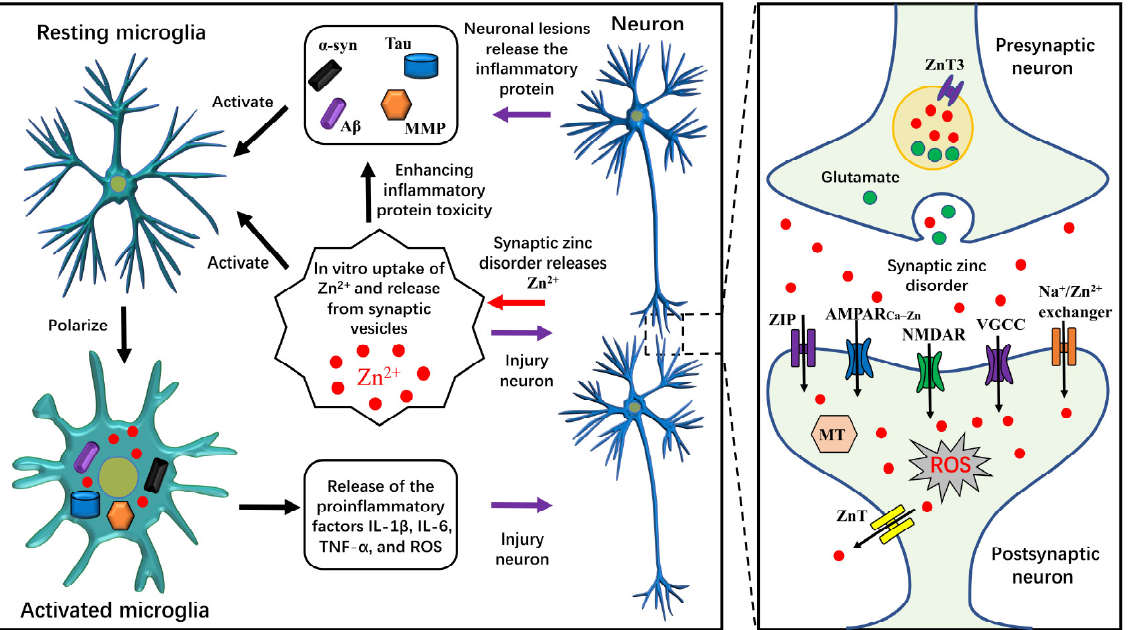
Figure 1. Zinc homeostasis disorder in the brain promotes neuroinflammation. When diseases, such as AD and PD, and conditions, such as cerebral ischemia and hypoxia, lead to synaptic function disorder, synaptic zinc levels are in a state of fragile balance or imbalance. In this case, zinc supplementation increases the extracellular Zn 2+ and synaptic Zn 2+ content in the brain, leading to the uncontrolled release of a large amount of Zn 2+ from the synapse to the extracellular space. Large amounts of extracellular Zn 2+ damage neurons in several ways: 1. Zn 2+ flows directly into neurons, thus promoting oxidative stress and causing neuronal death; 2. Zn 2+ damages neurons by activating microglia to produce proinflammatory factors and ROS; 3. Zn 2+ damages neurons by enhancing the expression and neurotoxicity of inflammatory proteins ( α -syn, Tau, A β , and MMP). Therefore, patients with disorders involving abnormal synaptic function should strictly control zinc uptake. α -synuclein ( α -syn); Alzheimer’s disease (AD); Parkinson’s disease (PD); β -amyloid (A β ); matrix metalloproteinase (MMP); interleukin (IL); tumor necrosis factor- α (TNF- α ); reactive oxygen species (ROS); zinc transporter (ZnT); Zrt/Irt-like protein (ZIP); Ca 2+ -and Zn 2+ -permeable GluR2-lacking AMPA ( α -amino-3-hydroxy-5- methyl-4-isoxazole propionic acid) receptors (AMPAR Ca-Zn ); N-methyl-d-aspartate receptor (NMDAR); voltage-gated calcium channel (VGCC); metallothionein